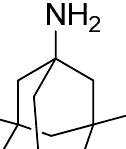
the affinity of antipsychotic drugs towards NMDAR (PDB#1PBQ) by molecular docking